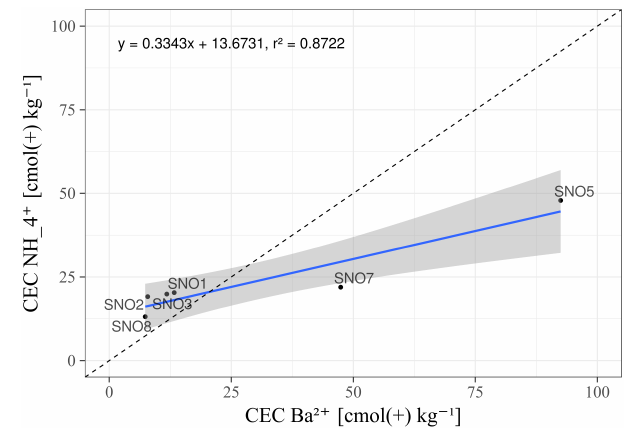
Figure 12. Relation between the CEC (cmol ( + ) kg − 1 ) measured with NH + and the Ba 2 + obtained from the difference image anal- 4 ysis of the natural soil samples. The blue line represents a linear model with its 95% confidence interval in grey ( p< 0 . 01). The dot- ted line has a slope of